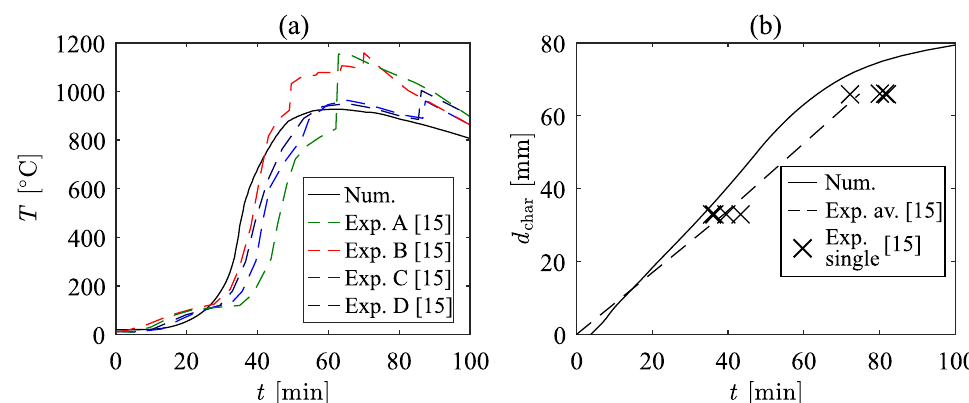
Fig. 13 Fire scenario 3. a The development of temperatures at the interlayer between first and second lamella. b The development of charring depth